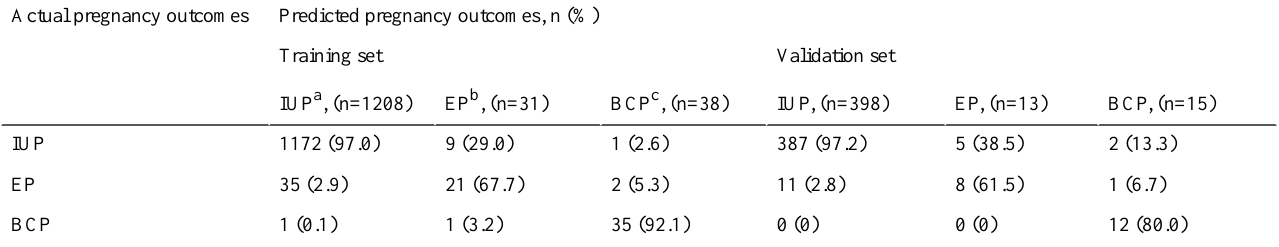
Table 3. The predicted and actual occurrence of different pregnancy outcomes in our